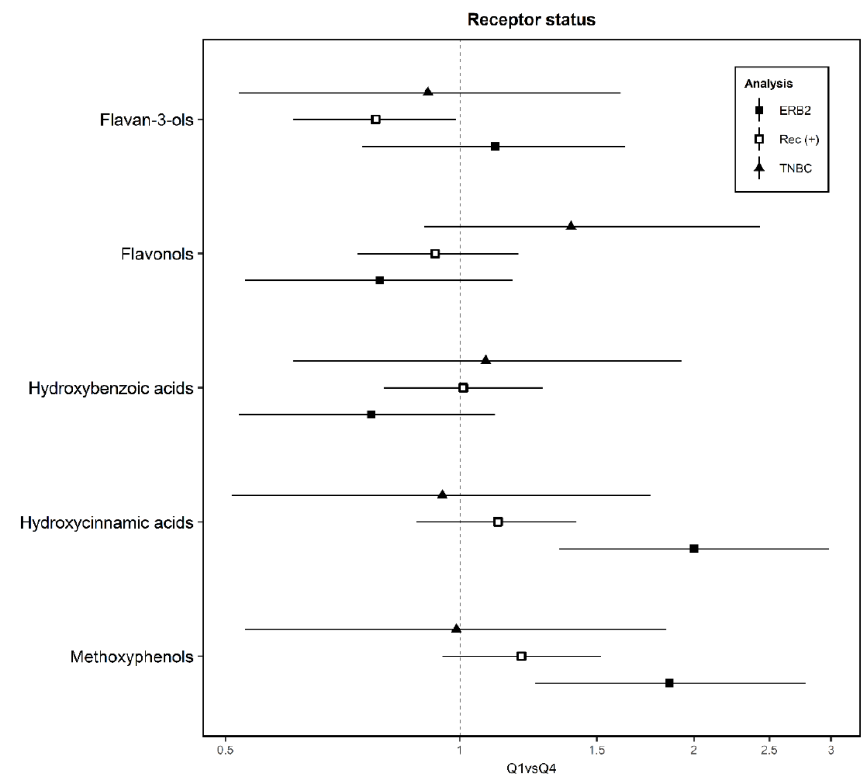
Figure 4. Association between estimated intake of subclasses of polyphenols with breast cancer by receptor status, in the Multi-Case-Control (MCC)-Spain study. ERB2: Erb B-2 receptor; Rec ( + ): hormonal receptor positive; TNBC: triple negative breast cancer. Adjusted ORs of Q4 vs. Q1 and 95% confidence intervals (CI) of BC by receptor status according to polyphenol intake. ORs were adjusted for age, socioeconomic status, BC family history, body mass index, smoking, physical activity, energy, NSAIDs, age of menarche, number of children, past alcohol intake, hormone replacement therapy and oral contraceptives consumption, and area of residence (random effects).